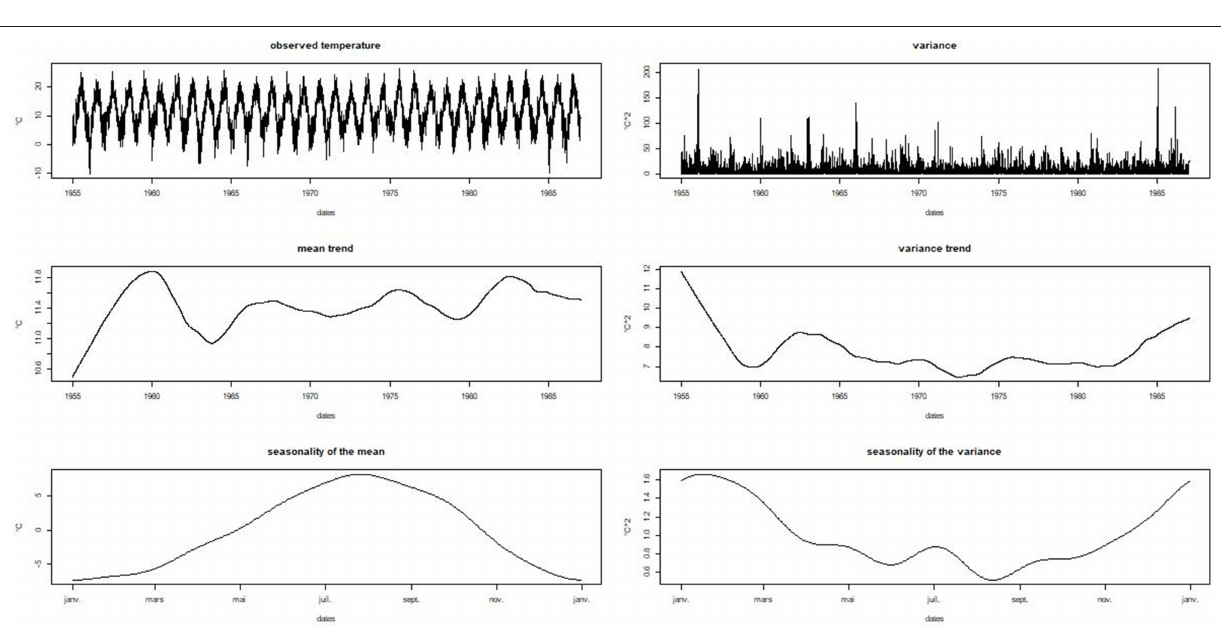
FIGURE 3 | Same as Figure 2 but for period 1955–1986